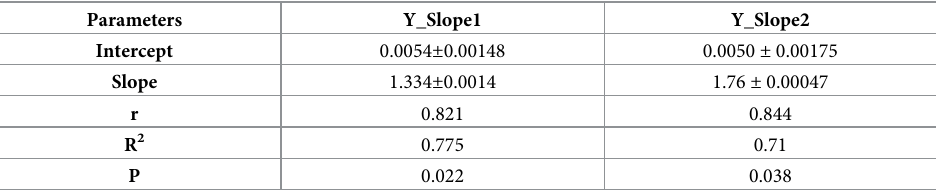
Table 3. Regression analysis of SKT signal parameter